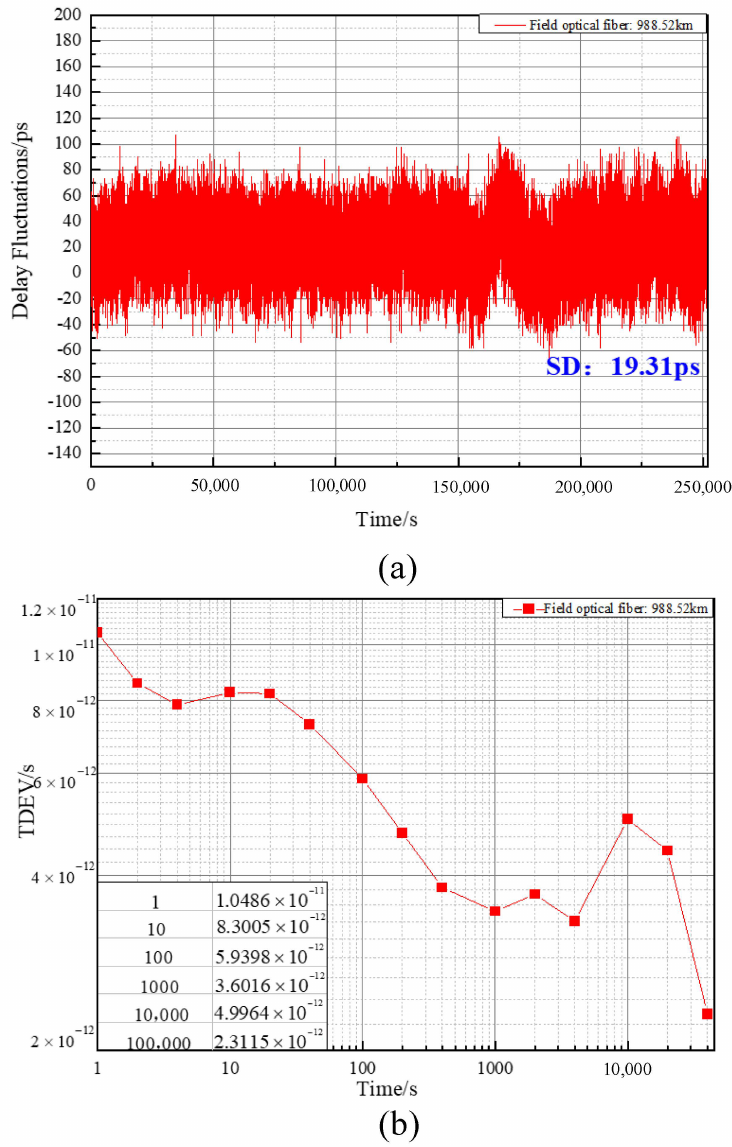
Figure 9. ( a ) Instability of the propagation delay of the 988.52-km field optical fiber link. ( b ) TDEV results of the 1-PPS time transfer via the 988.52-km field optical fiber